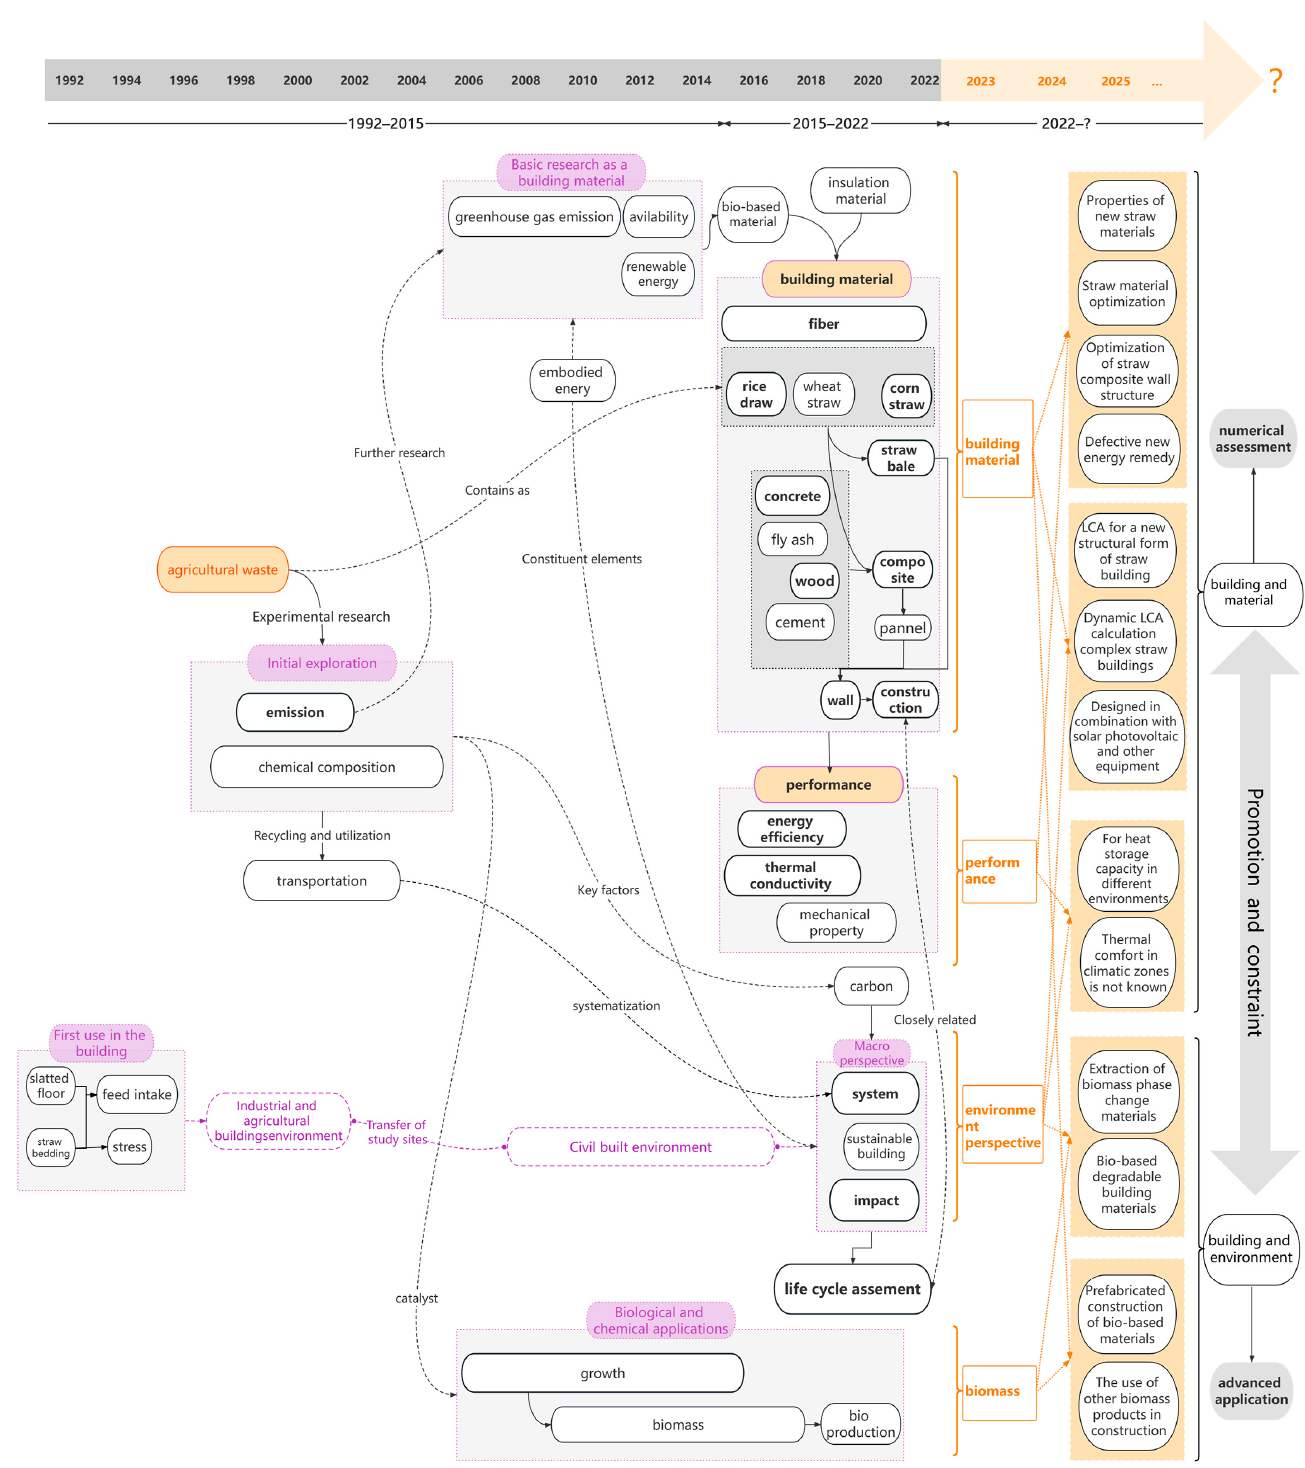
Figure 9. Development of straw building materials in the fi eld of energy e ffi ciency composed be- 1992 and tween 1992 and 2022.